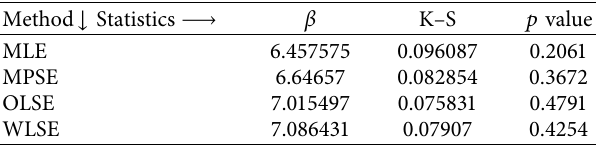
Table 20: Diferent estimators with K–S and its p values for data set IV.